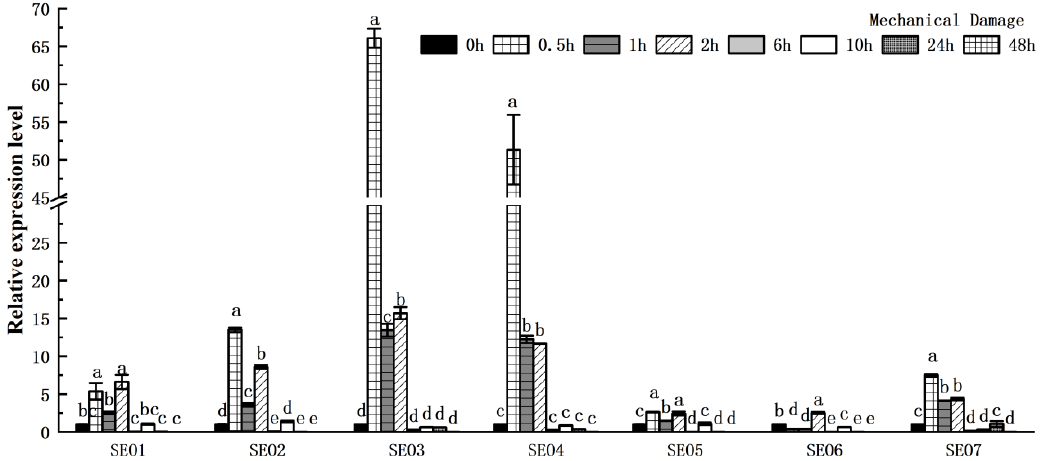
Figure 9. Relative expression variation of HbSEOs subjected to mechanical injury treatments. To calculate the relative expression level of each gene at different treatment times, the expression level of each gene in 0 h was used to normalize the expression levels at other times. Different small-case letters signify statistical differences between means following Duncan’s one-way ANOVA ( p < 0.05) for same genes.